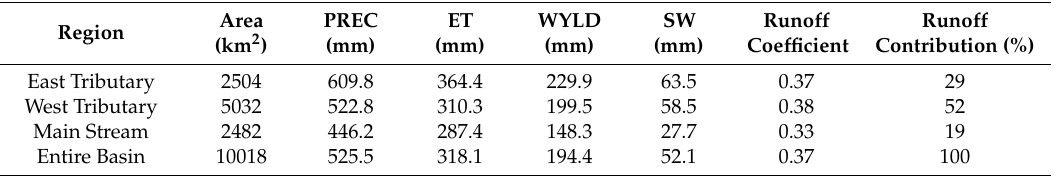
Table 3. Water balance components for different regions.